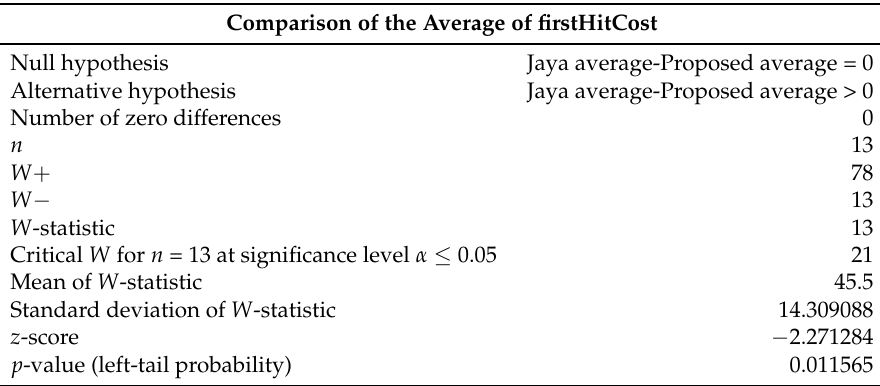
Table 12. Wilcoxon signed rank test on the data in Table 10 (sample size =